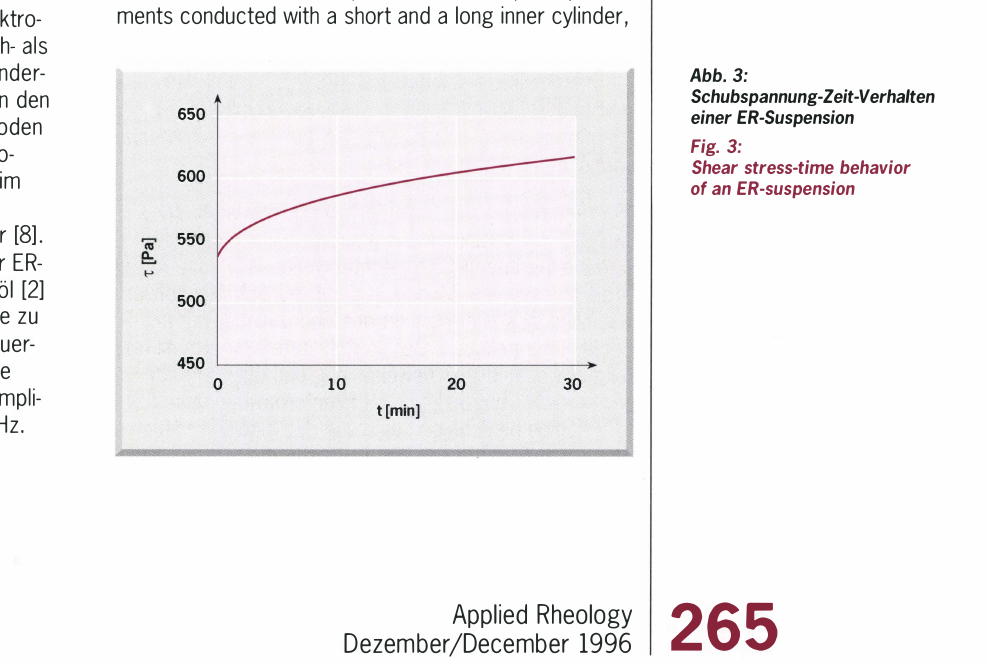
Fig. 3: Shear stress-time behavior of an